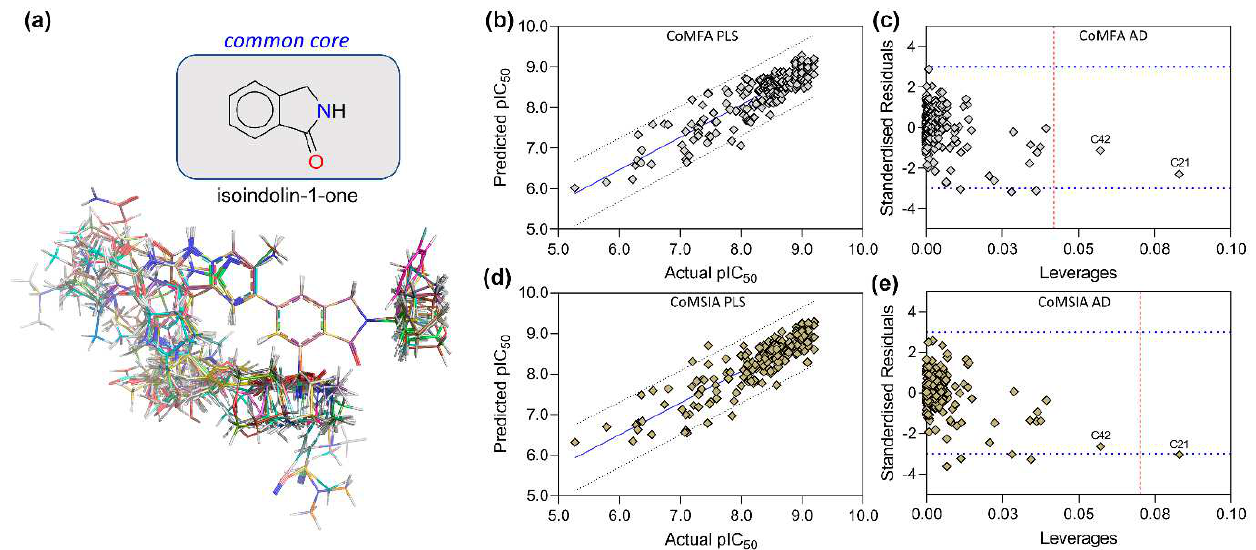
Figure 5. Molecular alignment and CoMFA-CoMSIA statistical plots. ( a ) The dataset compounds are aligned to the common skeleton isoindolin-1-one. ( b ) and ( c ) show the partial least squares (PLS) correlation plot and applicability domain (AD) analysis (Williams plot) of the CoMFA model by taking every compound in the dataset. ( d , e ) show the PLS plot and AD analysis of the CoMSIA model. The warning leverage (h*) for CoMFA (h* = 0.042) and CoMSIA (h* = 0.070) is shown in dotted red lines in the Williams plot. Table 7. Statistics of the CoMFA models of training set compounds of PI3Kγ.